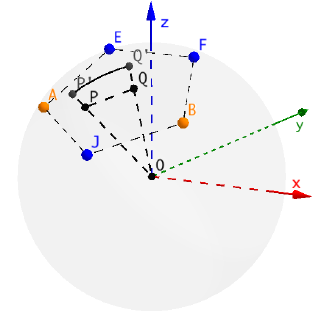
Figure 2. The difference between segment in the plane and its projection on the